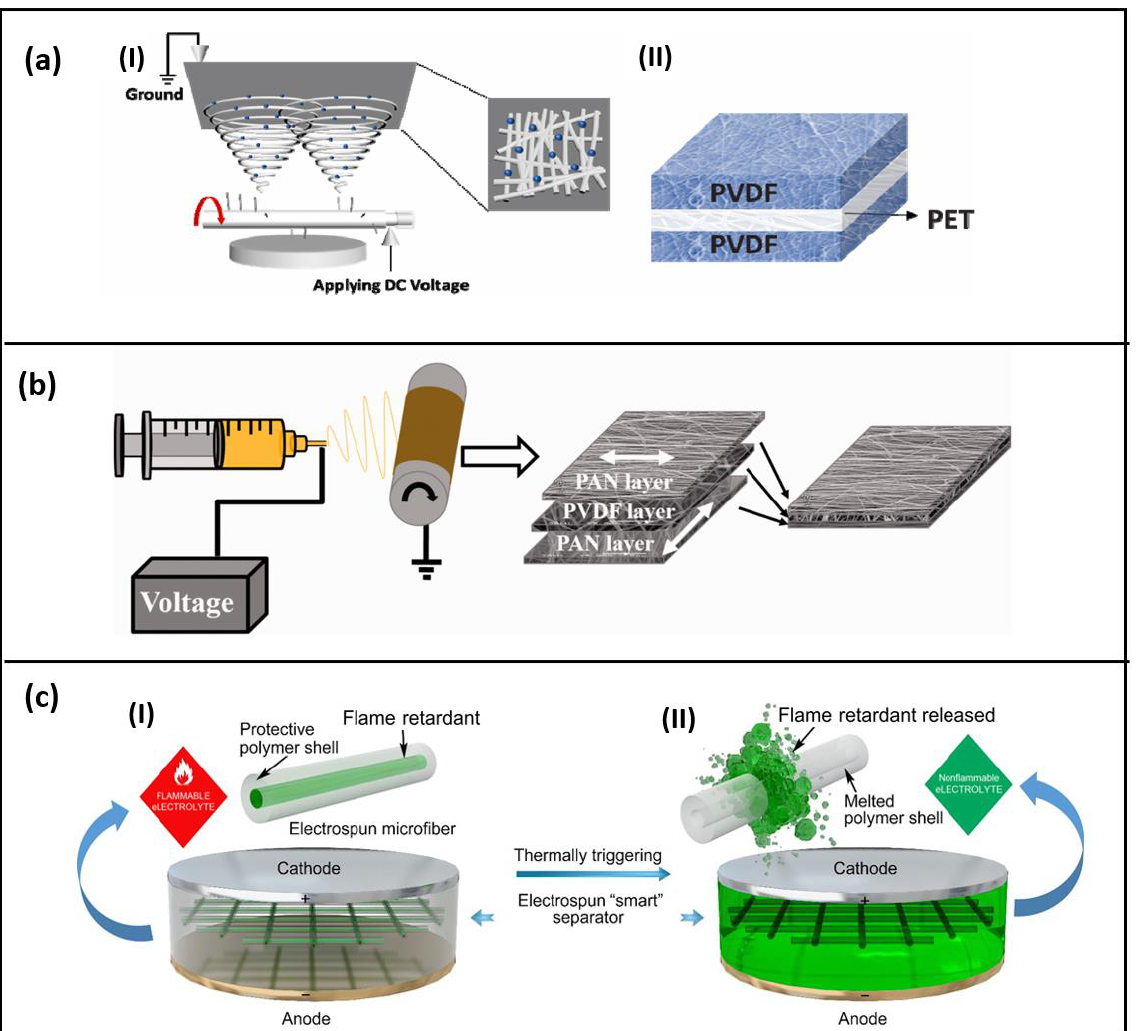
Figure 6. ( a ) Schematic of syringeless electrospinning of PVDF non-woven composite Web (I) Struc- ture of nonwoven separator (II) (reused with copyrights from Ref. [69] 2022, Elsevier) ( b ) Fabrication of directionally oriented composite nanofibers (reused with copyrights from Ref. [22] 2022, Sage) ( c ) Smart electro-spun nanofibers with core-shell structure (I)-before thermally triggering (II)-after thermally triggering releasing flame retardants that suppress ignition. (reused with copyrights from Ref. [72] 2017, Science advances).